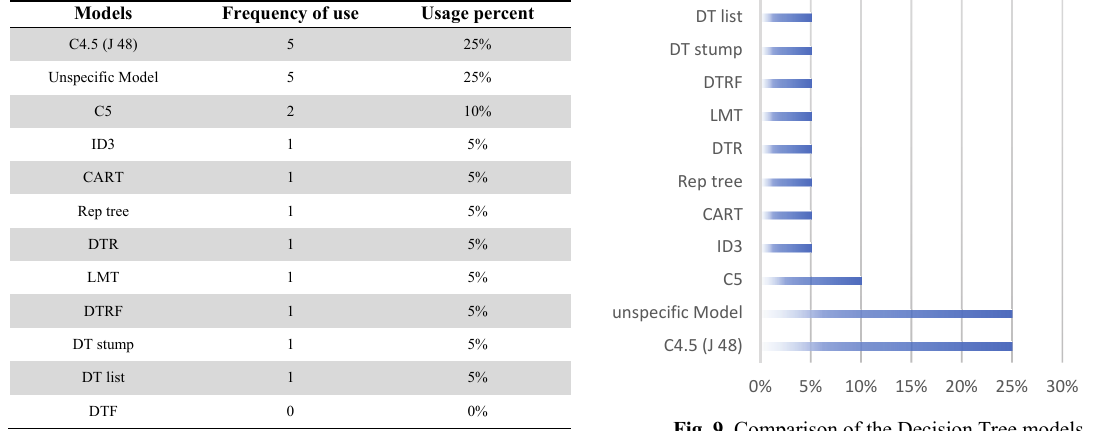
Comparison of the Decision Tree models